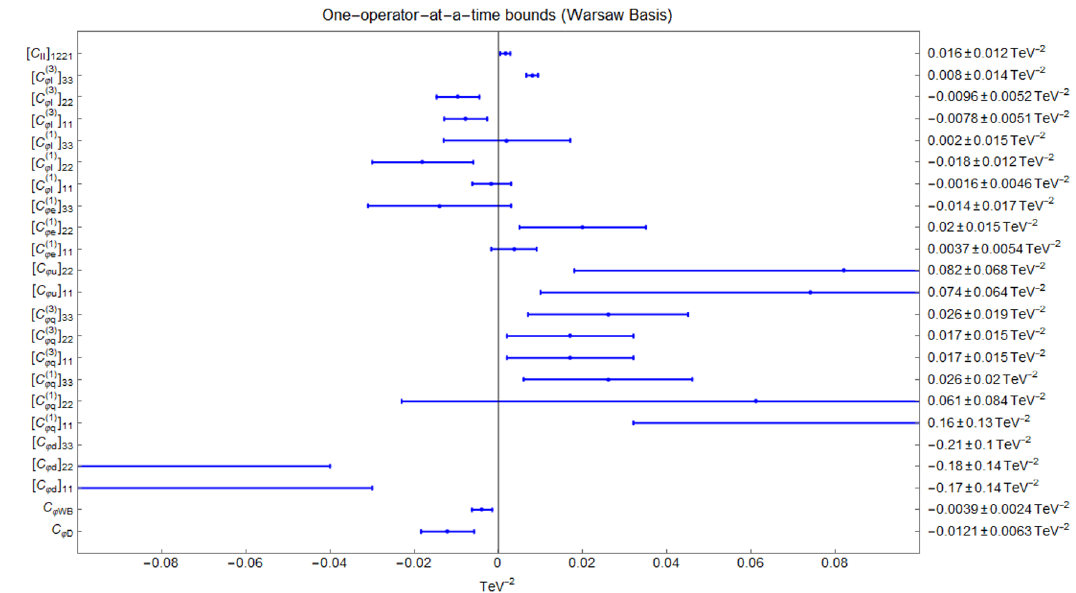
Figure 7 . Constraints obtained from our final electroweak fit, which uses traditional pole observ- ables (table 1 and table 2), LHC A FB data (table 3) and D0 A FB data [41], when considering one Warsaw-basis operator at a